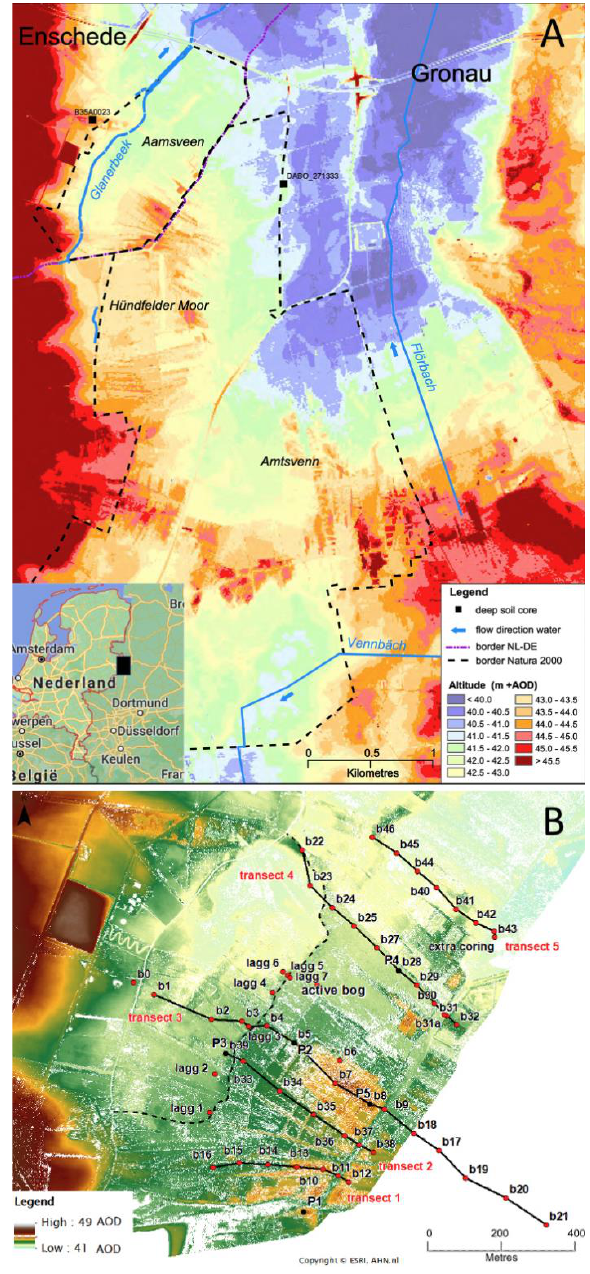
Figure 1. (A) Location and altitudinal map of the Aamsveen and Amtsvenn-Hündfelder Moor in the Dutch-German border area; (B) topography of the Aamsveen (from the Dutch AHN elevation map) with locations of transects and corings. The Middenpad is indicated by